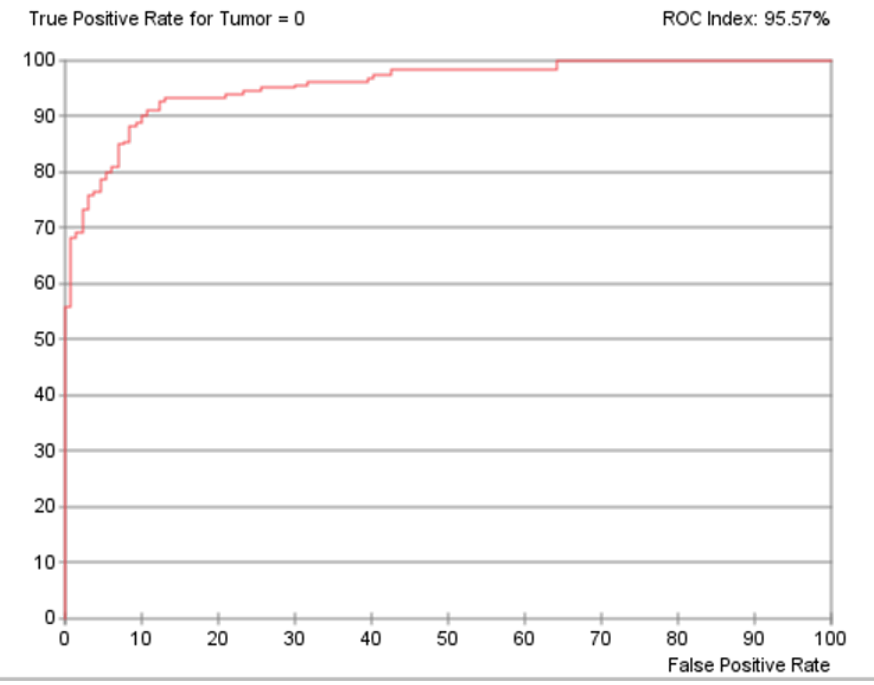
Figure 13. ROC curve for the expert model. Table 5. Summary of performance indices of BN model.